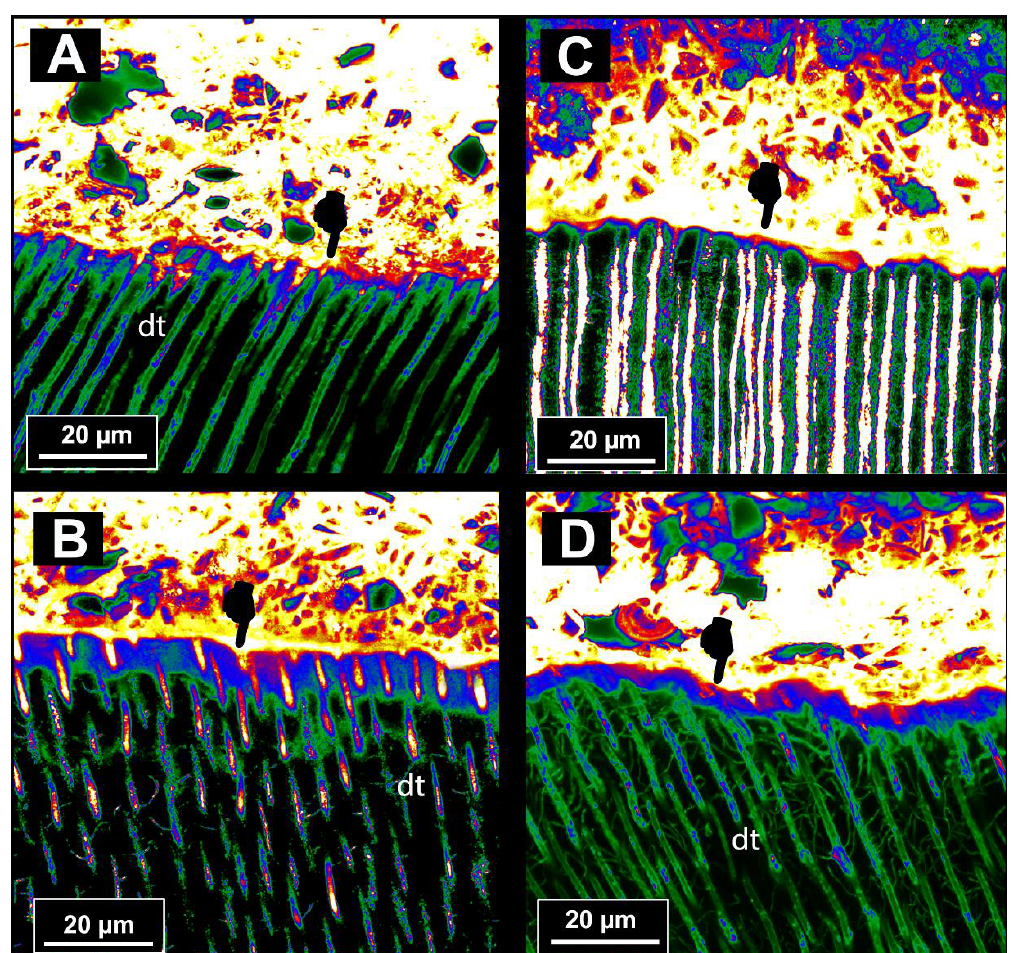
Figure 3. Confocal images of interfaces at 24 h or after short-term cycle load aging. ( A ) CLSM projection image exemplifies the interfacial characteristics at 24 h of the bond – dentine interface created by application of the resin-modified glass ionomer cement (RMGIC) onto dentine without PAA pre-treatment. It is possible to see a permeable gap-free interface that absorbed the fluorescein solution through the dentinal tubules (dt). In particular, this highlighted the existence of a thin interdiffusion layer (pointer). ( B ) CLSM projection at 24 of a representative bond-dentine interfaces created by RMGIC applied onto dentine pre-treated with PAA. In this case, it is possible to appreciate a thicker interdiffusion layer that absorbed the fluorescein solution through the dentinal tubules (dt) ( C ) A representative CLSM projection of a RMGIC-dentine interface created by applying the RMGIC onto a dentine pre-treated with no PAA and subjected to load cycling. It is possible to observe that such an aging protocol had no effect on the overall morphology of the interface, although the interdiffusion layer appears slightly thinner (pointer) than that observed in picture ( A ). ( D ) A representative CLSM projection of a RMGIC-dentine interface created by applying the RMGIC onto a dentine pre-treated with 10% PAA and subjected to load cycling. Also, in this case, it is possible to observe that such an aging protocol had no effect on the overall morphology of the interface, but the interdiffusion layer appears clearly thinner (pointer) than that observed in picture ( B ), which represents the same specimens subjected to no load-cycle aging.